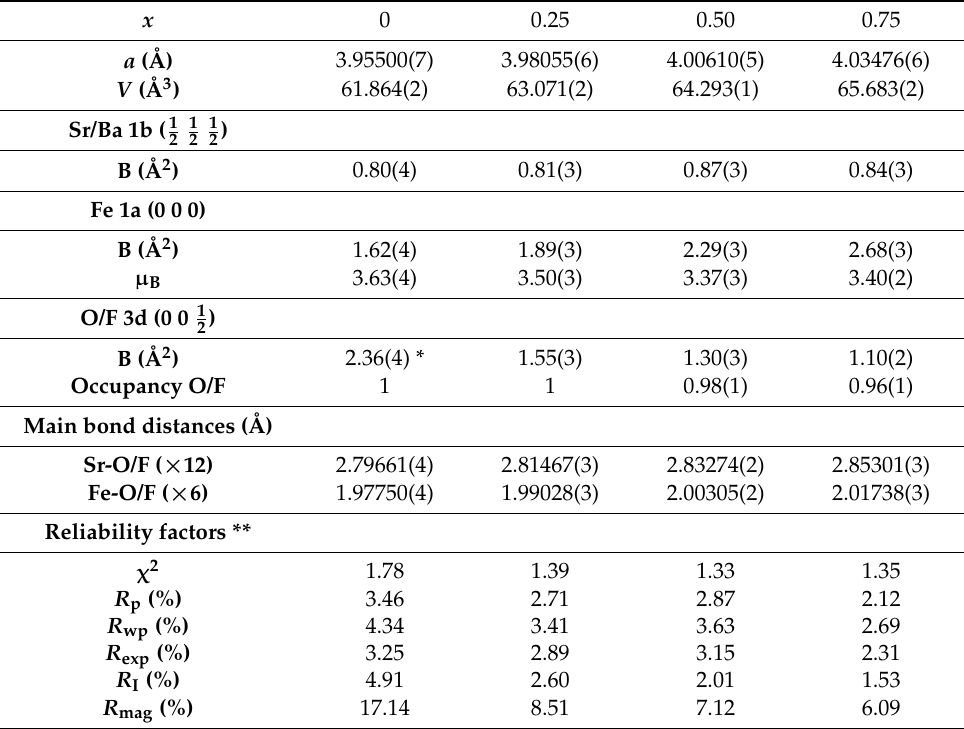
Table 1. Structural parameters for Sr 1– x Ba x FeO 3– y F y , refined in the cubic P m-3m space group,